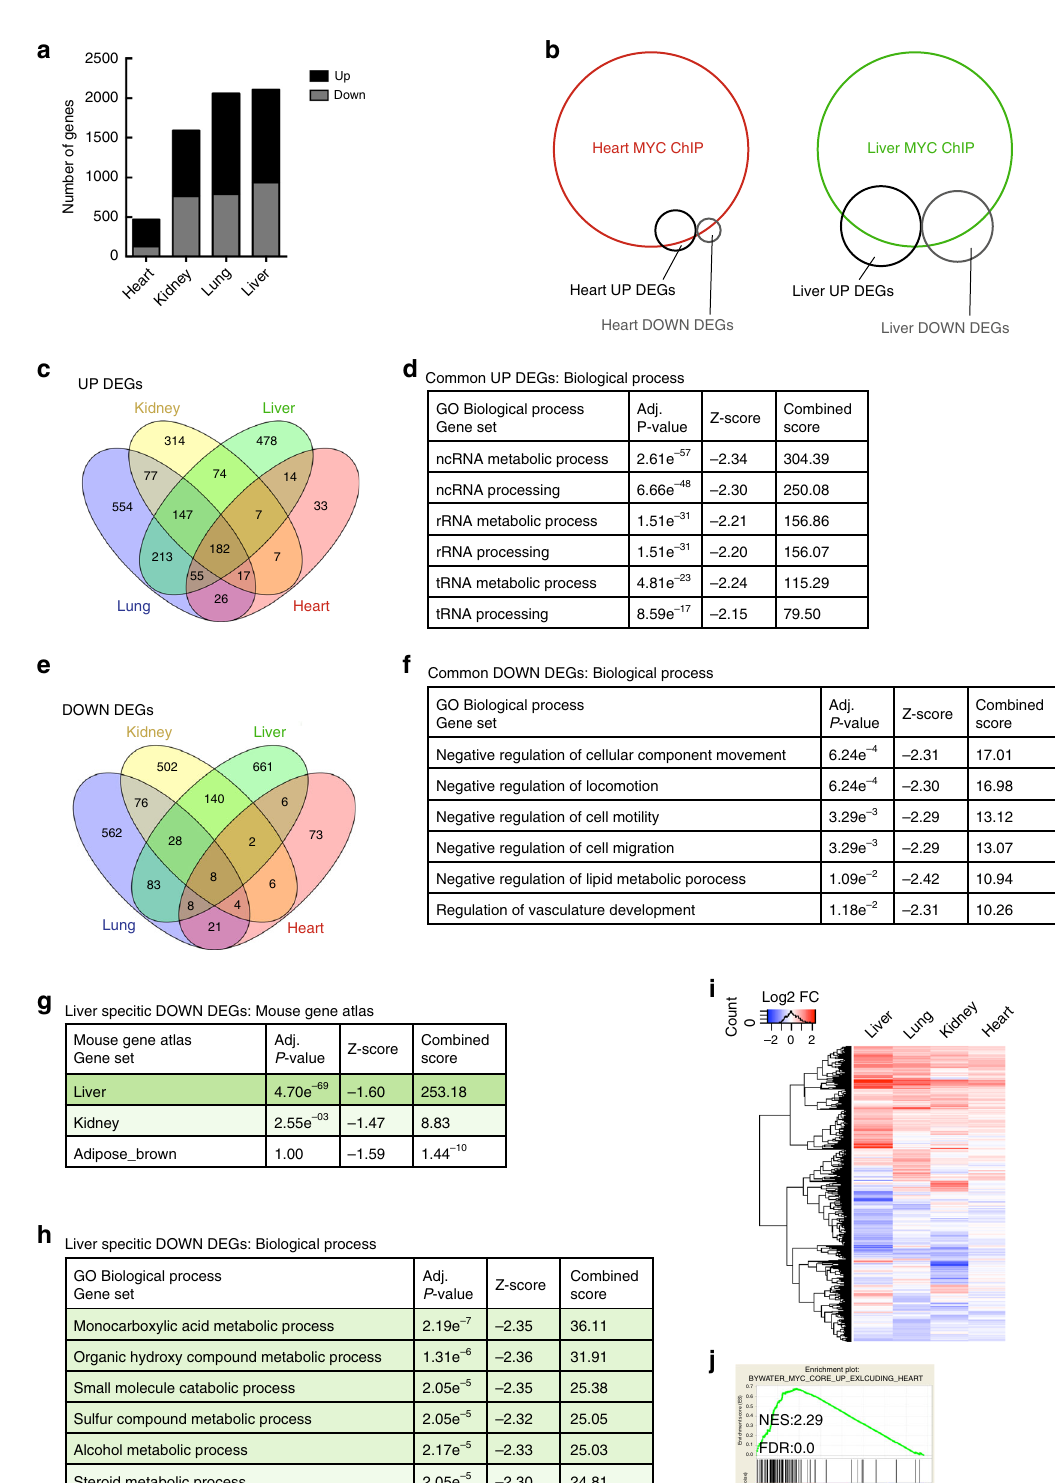
Liver specitic DOWN DEGs: Biological